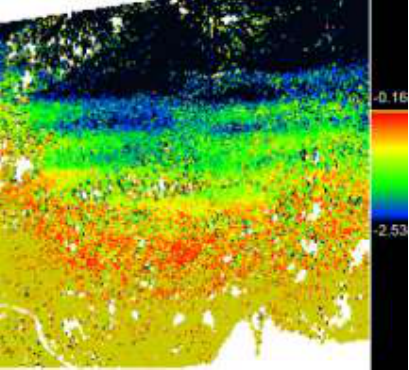
Figure 15. Averaged y-parallaxes, Cartosat-1 stereo model